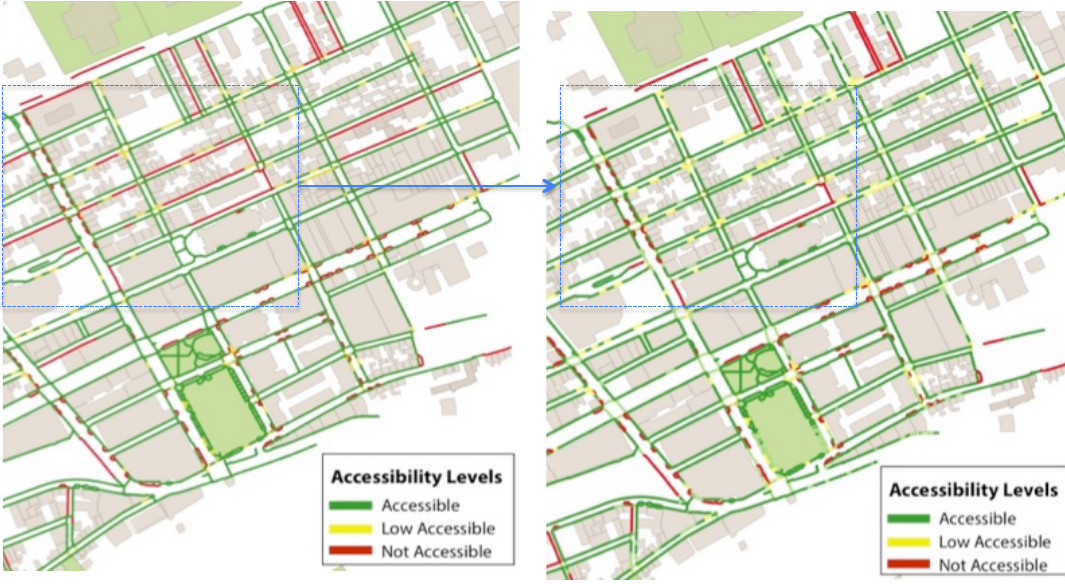
Figure 9. Accessibility map after simulation of Policy 3 change.